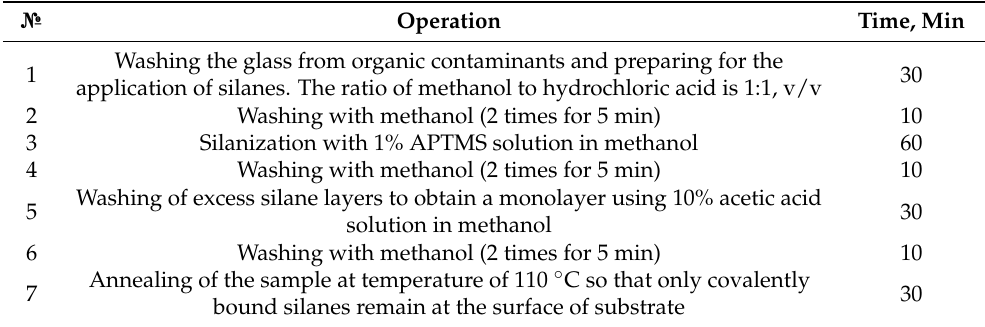
Table 2. Silanization stages of glass